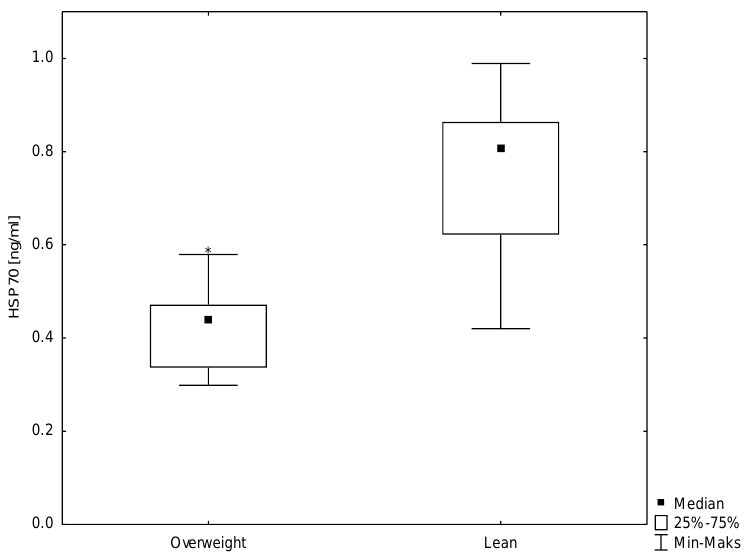
Figure 1. A box-whisker plot for the concentrations of HSP70 in the study groups. * statistically significant difference at p < 0.05.